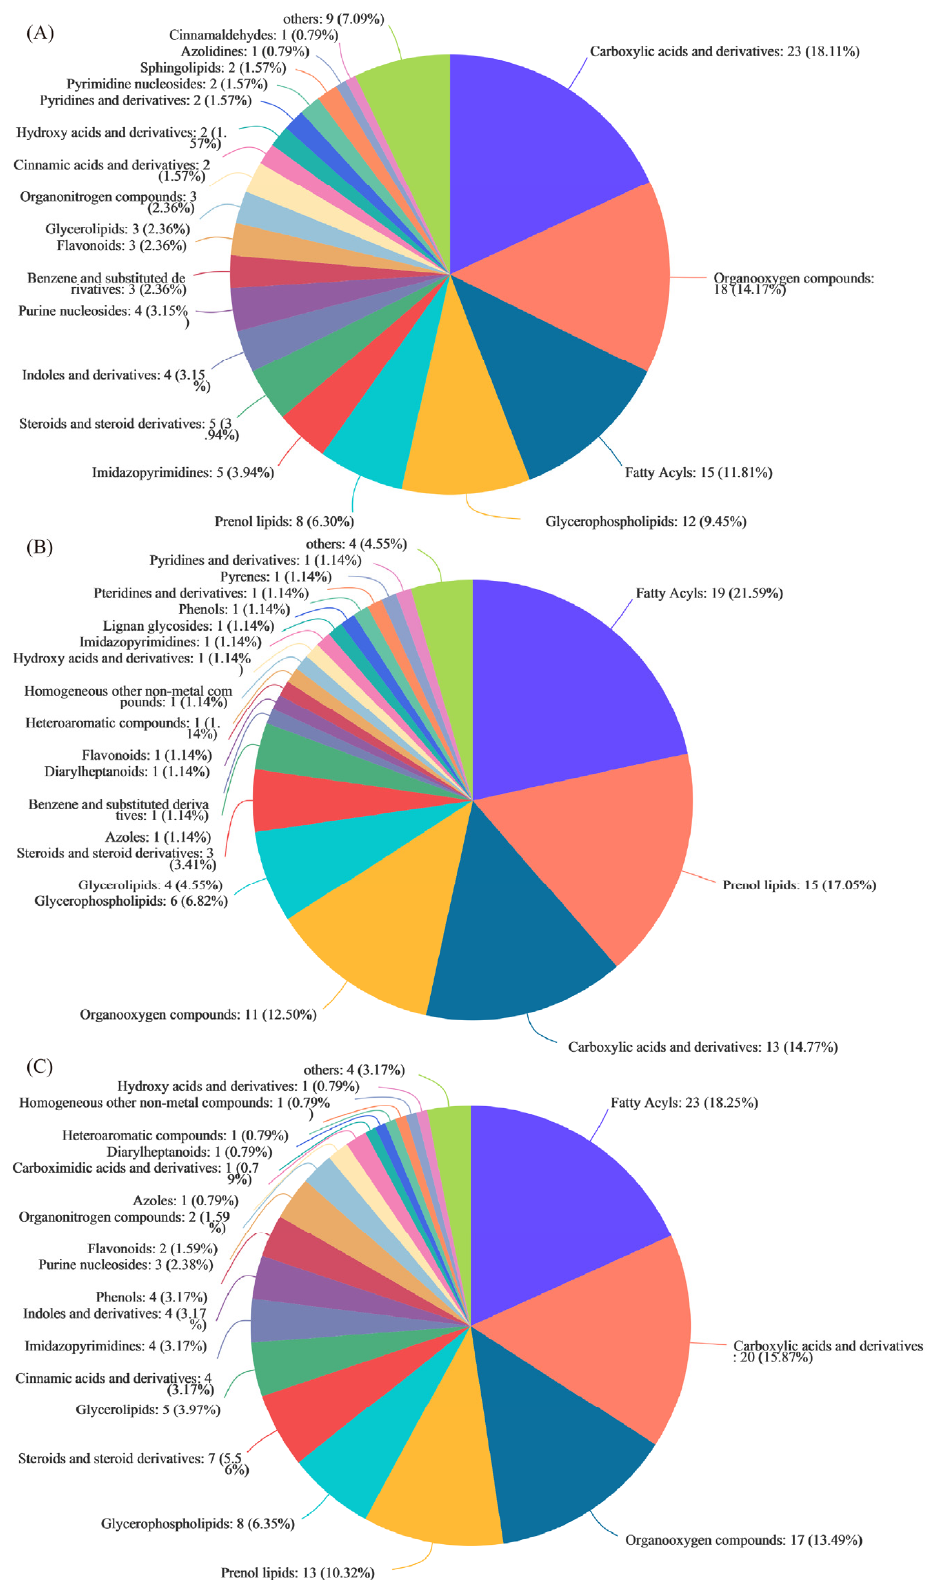
Figure 3. Statistical map of compounds. ( A ) HY5H_vs_NJ5718, ( B ) YNX28H_vs_NJ5718, and ( C ) HY5H_vs_YNX28H. HY5H, Hongyang 5 hao; YNX28H, Yangnongxiang 28; NJ5718, Nanjing 5718.